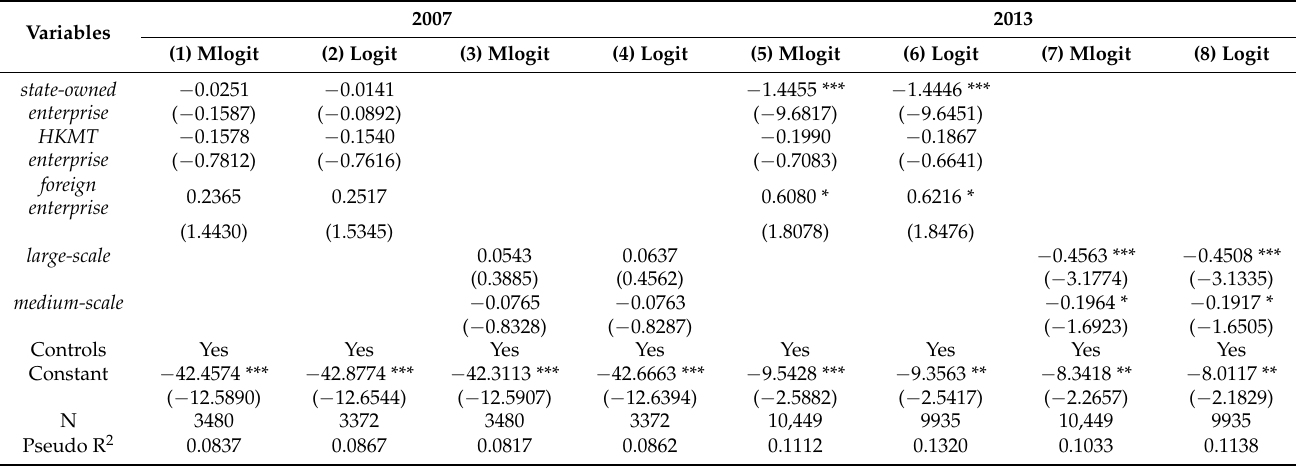
Table 16. Regression results of logit model for